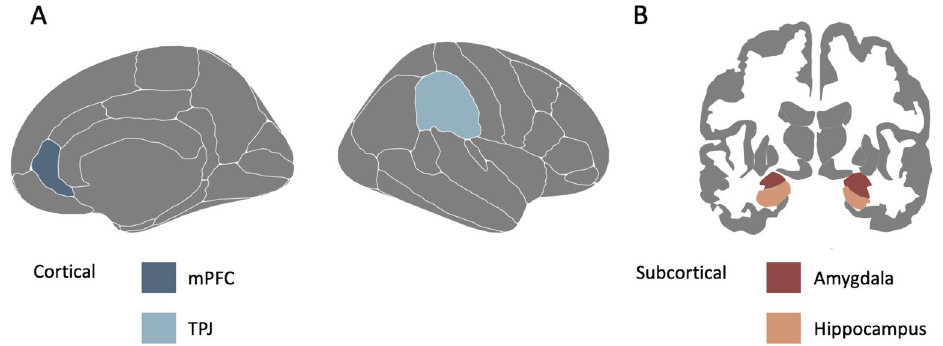
Figure 2. An overview of the ROIs used for neural analyses with in ( A ) cortical (social network) and in ( B ) subcortical (stress network) brain regions. In total 4 ROIs are presented in the figure. mPFC = medial prefrontal cortex, TPJ = temporoparietal